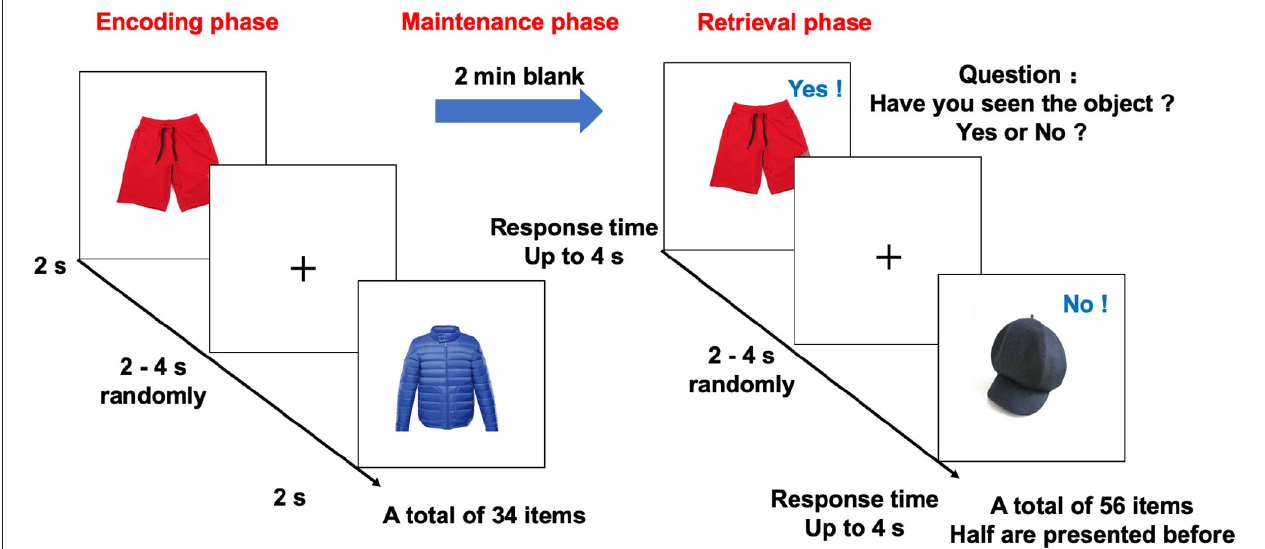
FIGURE 1 | Design of the memory task in the fMRI study. The memory task in the fMRI study, included encoding, blank (memory maintenance), and retrieval phases. In the encoding phase, 34 objects were sequentially presented for 2s. After a 2-min blank, the participants indicated whether the object was present or absent in the encoding phase as quickly as possible using two buttons of an MR-compatible button box. During retrieval, each object appeared on the screen until there was a response or up to 4s before the next letter was shown. The inter-object interval was randomly set between 2 and 4s. fMRI, functional magnetic resonance